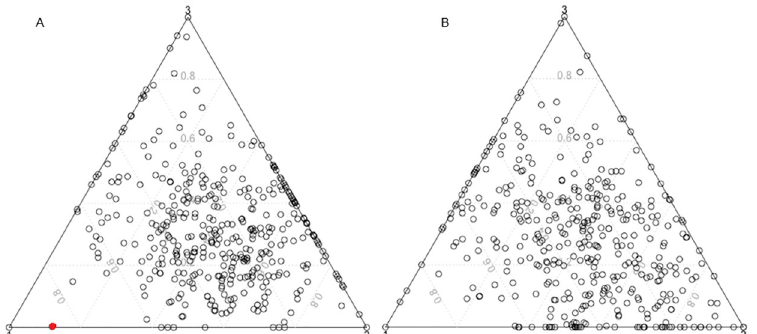
Fig 10. Ternary plots for ADA with 3D landmarks and p = 3. (A) Ternary plot for women. (B) Ternary plot for men. Each point corresponds to a foot, which is described by the alpha values. The corners of the triangle indicate the location of each of the archetypoids. For example, in the first ternary plot the red point represents a foot that is approximated by 88% of archetypoid 1 and 12% of archetypoid